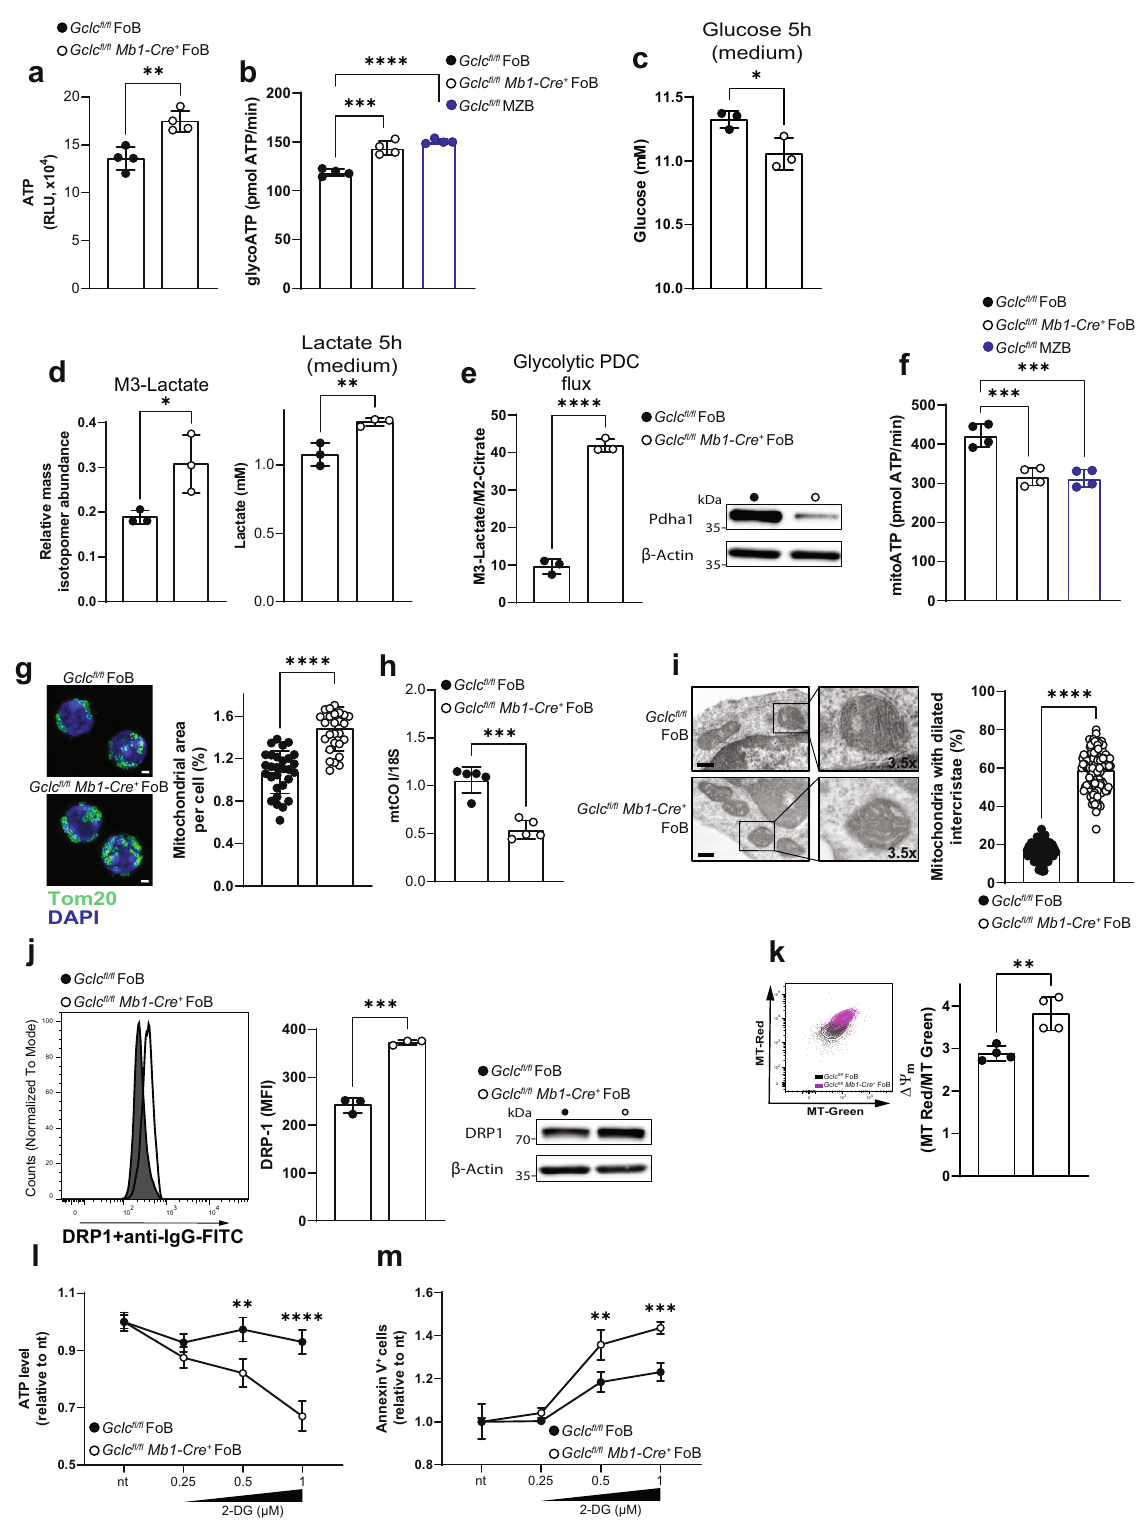
due to reduced NAD + regeneration which resulted in a lower NAD + /NADH ratio (Fig. 6l). Moreover, the expression level of the main subunit of CII (succinate dehydrogenase A, Sdha) was decreased in Gclc -de fi cient FoB (Fig. 6m). In line, ETC complex protein levels were reduced in mutant FoB compared to controls (Supplementary Fig. 6u). This included the CIII sub- unit core protein 2 and CIV subunit MTCO1, indicating